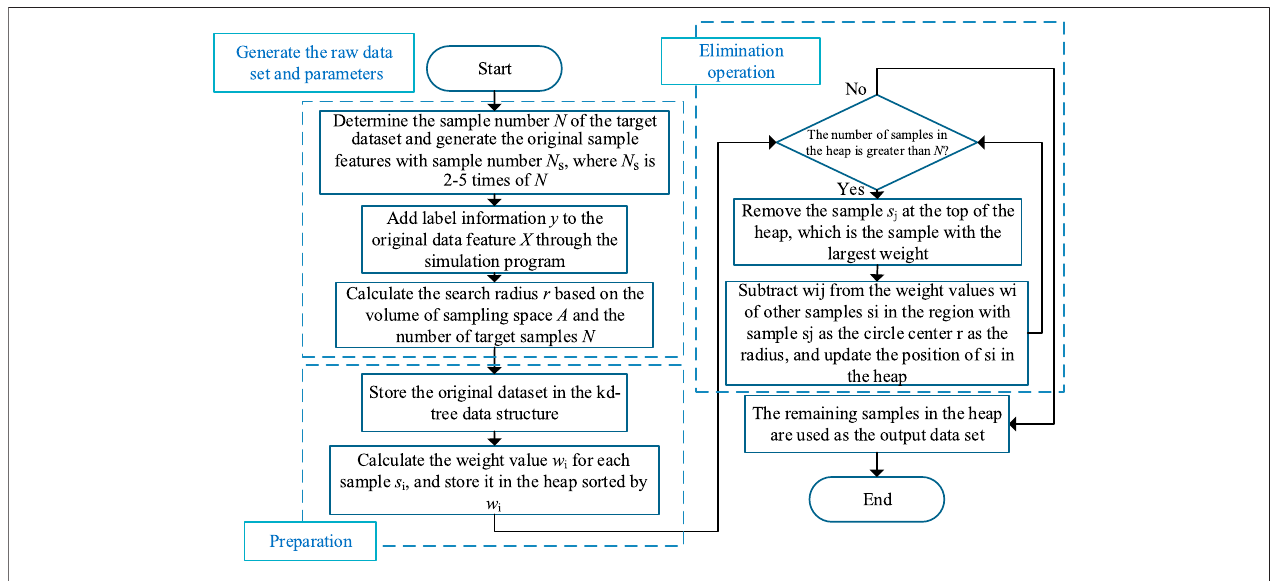
FIGURE 3 | Algorithm fl ow chart of weighted sample elimination.